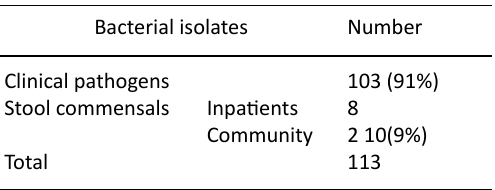
Table 3. Distribution of bla genes in different enterobacterial species detected by PCR.